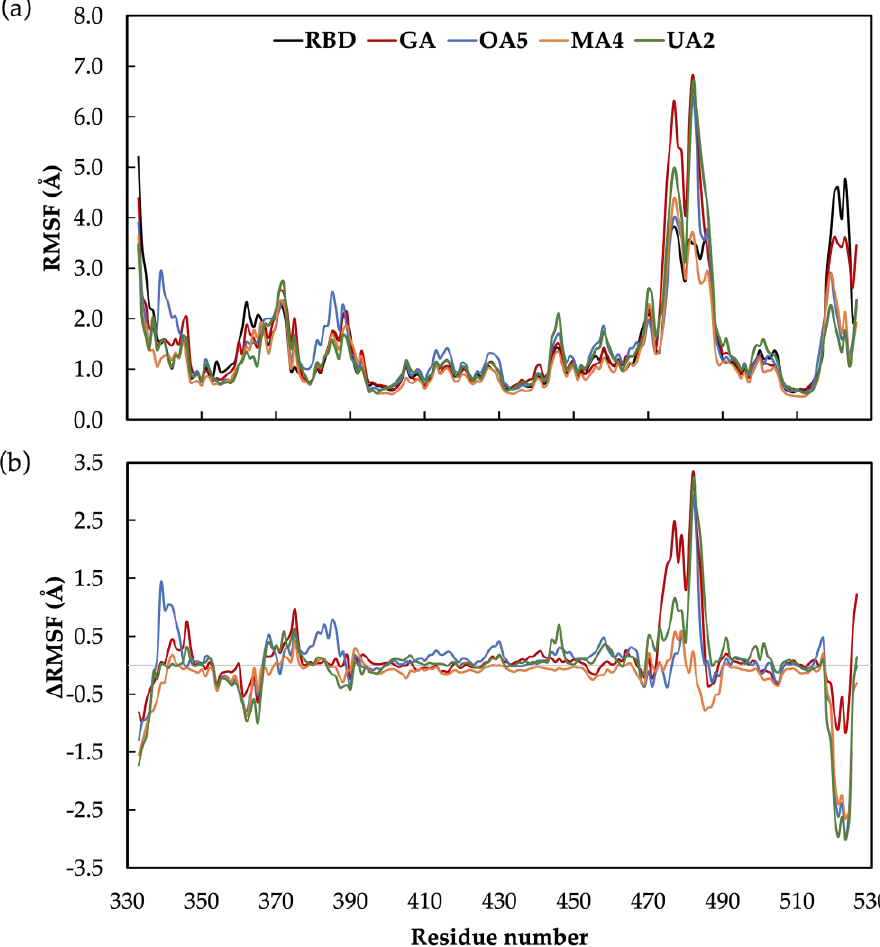
Figure 8. ( a ) RMSF values for the unbonded RDB domain and all the studied complexes of the pro- ∆ RMSF values relative to unbonded RBD domain of RMSF. Values are given in tein – ligand; ( b ) Δ RMSF values relative to unbonded RBD domain of RMSF. Values are given in Å . protein–ligand; ( b )